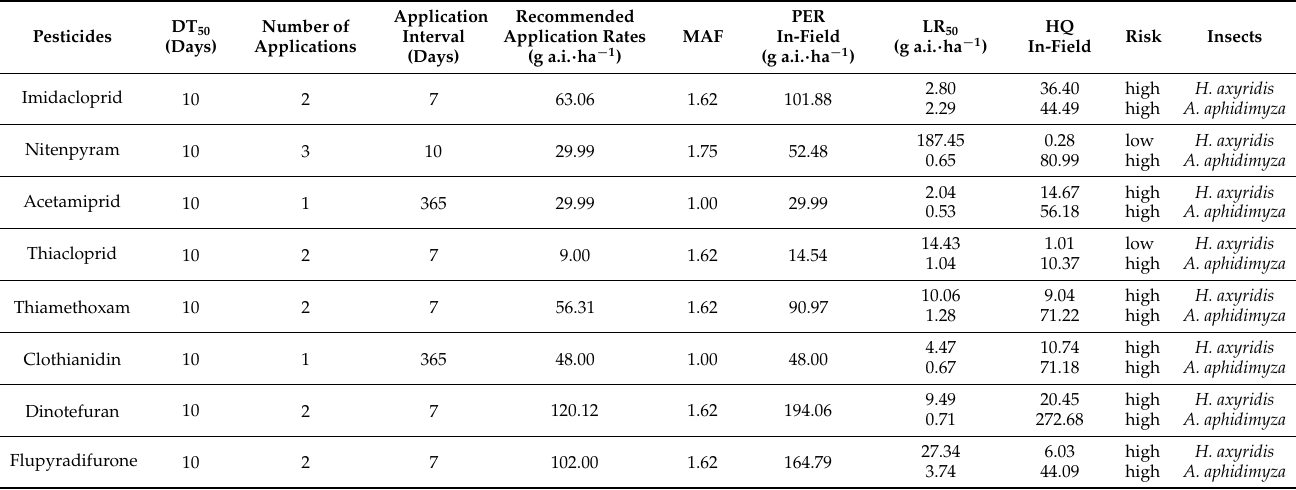
Table 3. Risk assessment of eight neonicotinoid pesticides to the natural enemies based on acute toxicity data and field exposure levels.